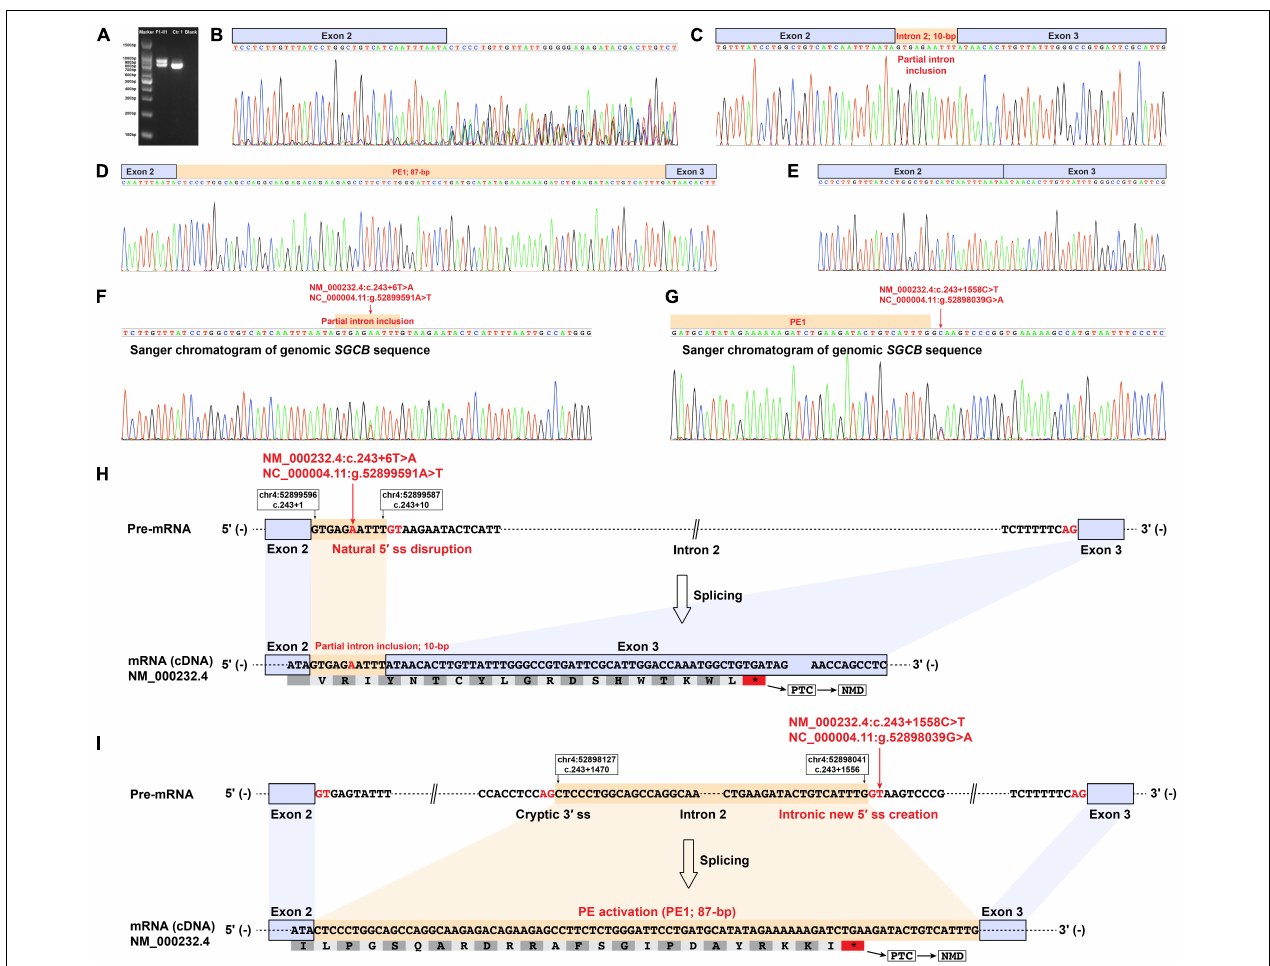
FIGURE 3 | Muscle-derived mRNA studies and genomic SGCB sequencing of patient F1-II1. (A) RT-PCR amplification of the aberrant SGCB transcripts from patient F1-II1 showed that the upper band was larger than the expected band, while the lower band was almost the same size as the expected band. (B) Direct Sanger sequencing of the aberrant SGCB transcripts could not recognize the overlapping sequences. (C–E) TA cloning of the aberrant cDNA fragments revealed a 10-bp sequence insertion and an 87-bp insertion of intron 2 sequence between SGCB exons 2 and 3 (PE1), and the normal splicing of SGCB exons 2–3. (F) Sanger sequencing of the genomic sequence around SGCB exon 2 revealed the c.243 + 6T > A variant. (G) Sanger sequencing of the genomic SGCB sequence around the PE1 revealed the c.243 + 1558C > T variant. (H) The schematic of the aberrant insertion of 10-bp sequence between SGCB exons 2 and 3 caused by the c.243 + 6T > A variant in SGCB . (I) The schematic of the aberrant 87-bp insertion of intron 2 sequence between SGCB exons 2 and 3 caused by the c.243 + 1558C > T variant in SGCB . Ctr1, a normal control; Blank, a reagent control; PE, pseudoexon; RT-PCR, reverse transcription-polymerase chain reaction; F, fragment; bp, base pair; PTC, premature termination codon; NMD, nonsense-mediated